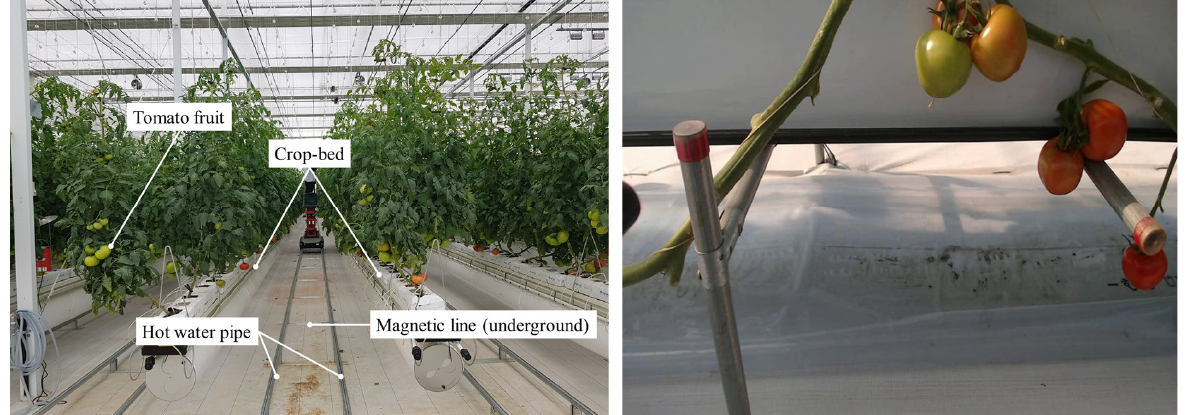
Figure 1. The greenhouse structure ( left ) and a sample captured image ( right ). The greenhouse is of a general hydroponic type, and hot water pipes and a magnetic line were installed between the two crop beds.